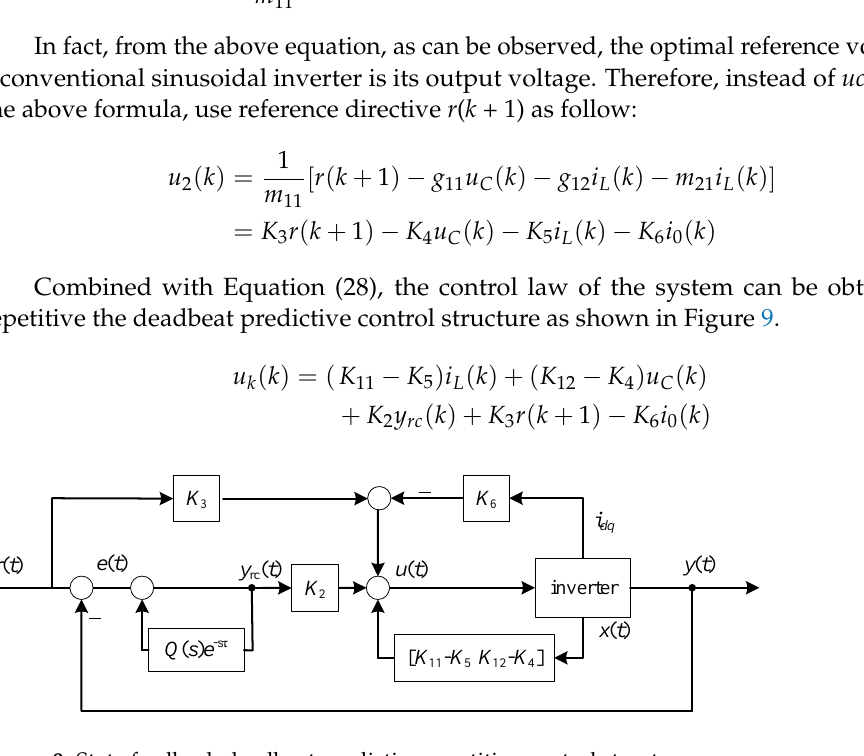
Figure 9. State feedback deadbeat predictive repetitive control